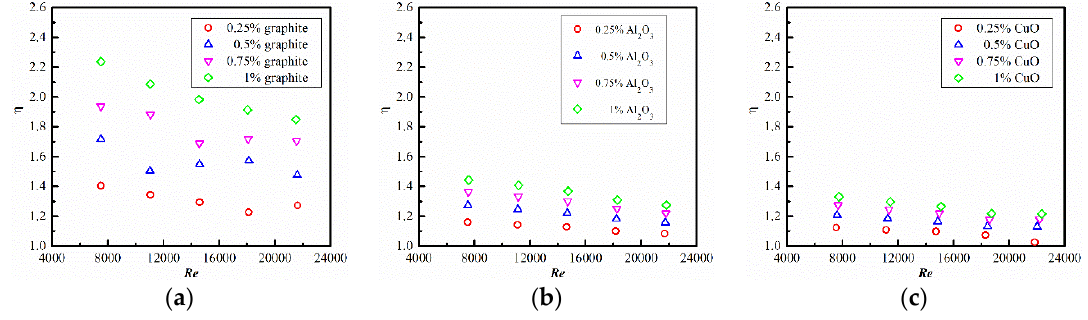
Figure 4. Variations of η with Re : ( a ) graphite; ( b ) A1 2 O 3 ; ( c ) CuO.